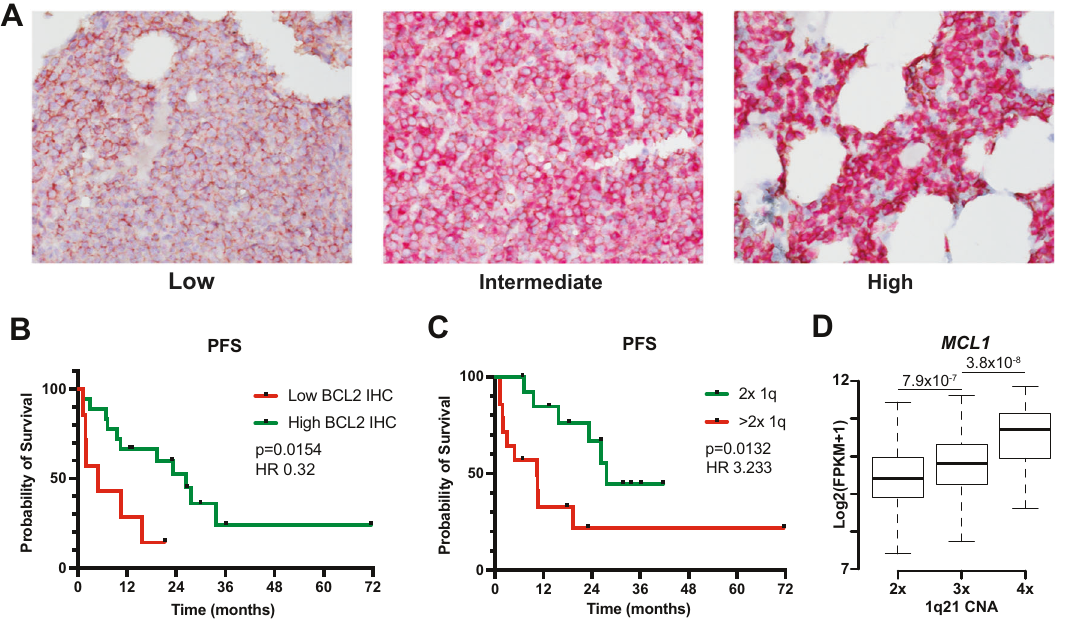
Fig. 2 Patient outcomes based on BCL2 IHC. Pre-treatment bone marrow biopsies were co-stained by IHC for BCL2 and CD138 to identify plasma cells. Samples were grouped into low and intermediate/high categories by a pathologist blinded to clinical correlates. A Representative images of bone marrow biopsies with low, intermediate, and high BCL2 (red) staining in CD138 (brown) plasma cells. B PFS of patients with low vs intermediate/high BCL2 staining in plasma cells. C PFS of patients treated with venetoclax having either 2 or greater than two copies of 1q. D Copy Number Alterations (CNA) at chromosome 1q21 and MCL1 expression in 670 Newly Diagnosed Multiple Myeloma (NDMM) cases from the CoMMpass study. (2×, N = 430; 3×, N = 197; 4× N = 43). P values computed using a t test are denoted on